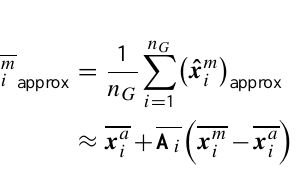
Fig. 7b. The latitudinal average time series of the percentage error in carbon monoxide calculated when the sampled points are screened with the quality flags (top) and not screened (bottom). The screened has the gap because TES performed no measurement in June 2005. (cid:2) ˆ (cid:3) ≈ E (cid:2) x a (cid:3) + E [ A ] E (cid:2) x − x a x E approx